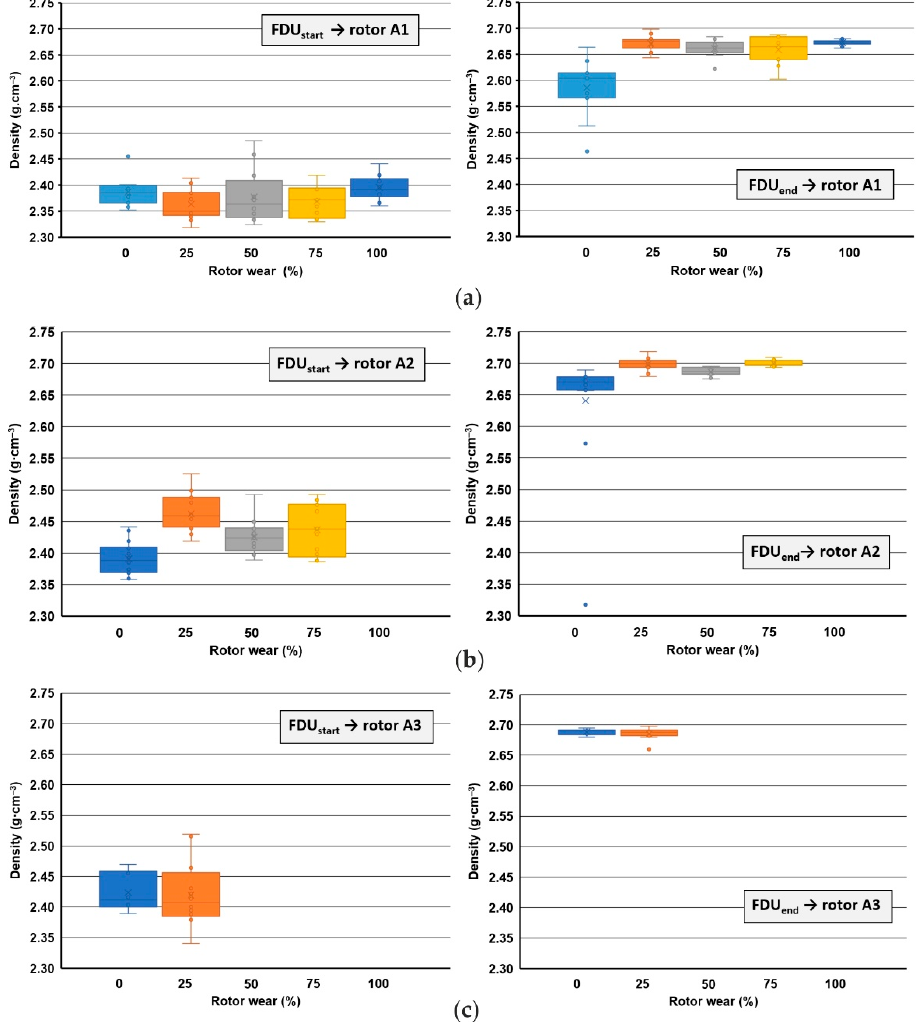
Figure 4. Comparison of densities values of samples solidified in vacuum within the rotors wear: ( a ) rotor A1 (series 1/VT to 5/VT); ( b ) rotor A2 (series 1/VT to 4/VT); ( c ) rotor A3 (series 1/VT to 2/VT).